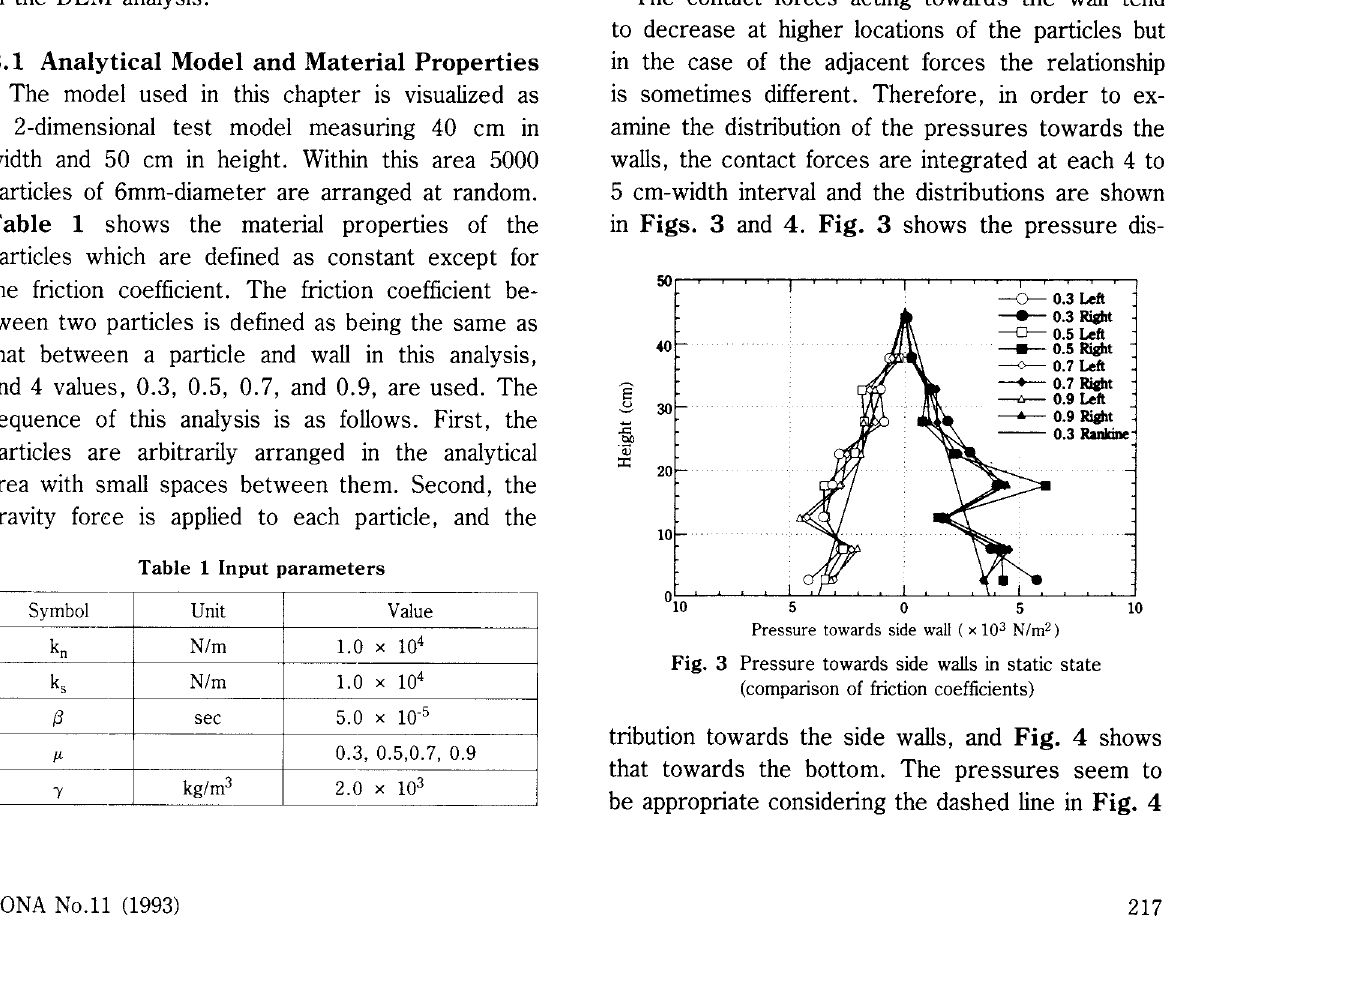
Static state of particles and contact forces on walls (comparison of friction coefficients)